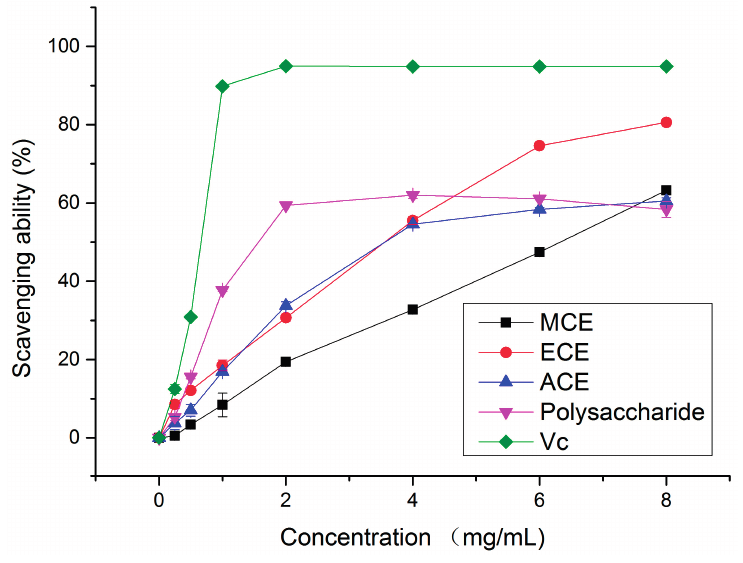
Figure 2. Free radical scavenging ability of different concentrations of various extracts and Vc on hydroxy radicals. MCE: methanolic crude extract; ECE: ethanolic crude extract; ACE: aqueous crude